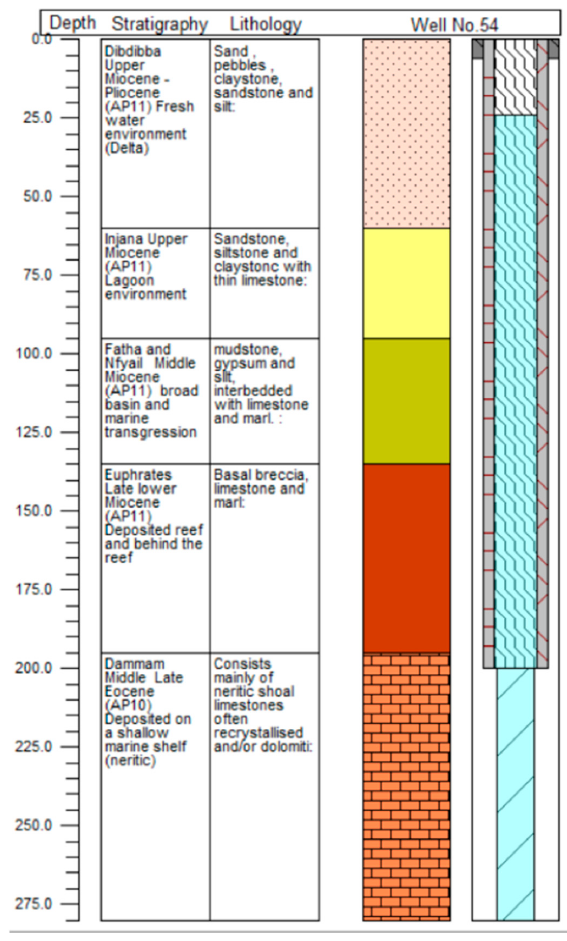
Figure 2. The stratigraphy and lithology of the formations in the study area.